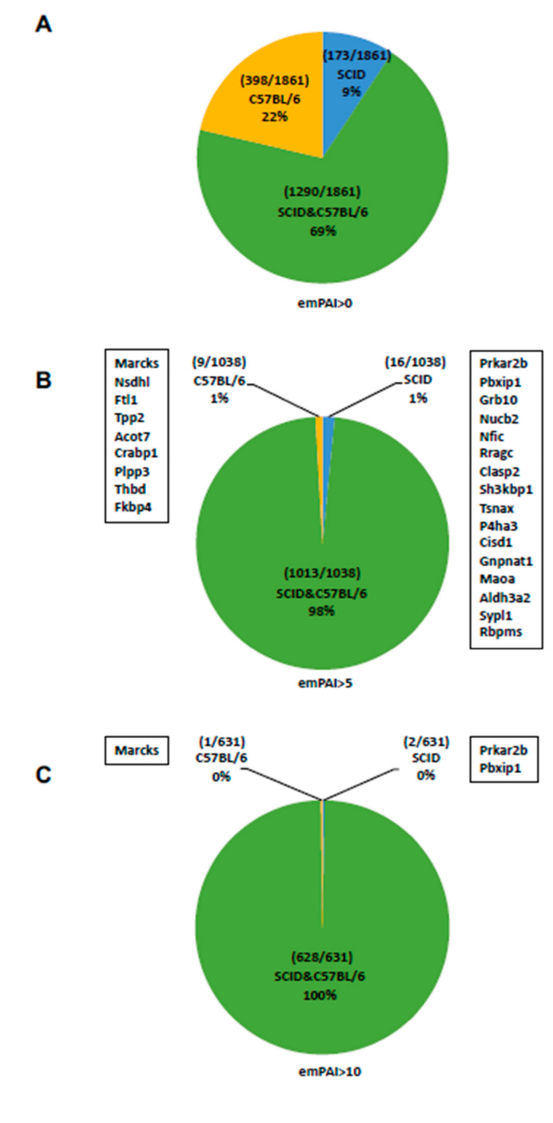
Figure 2. LC-MS / MS analysis of proteins expressed by mADMSCs. emPAI > 0: 1688 and 1463 proteins expressed by cultured C57BL / 6 mAdMSCs and SCID mAdMSCs, respectively (emPAI > 0). Among the 1688 proteins expressed by C57BL / 6 mAdMSCs, 398 were unique (emPAI > 0). Among the 1463 proteins of 1290 proteins (emPAI > 0) ( A ). emPAI > 5: C57BL / 6 mAdMSCs and SCID mAdMSCs each